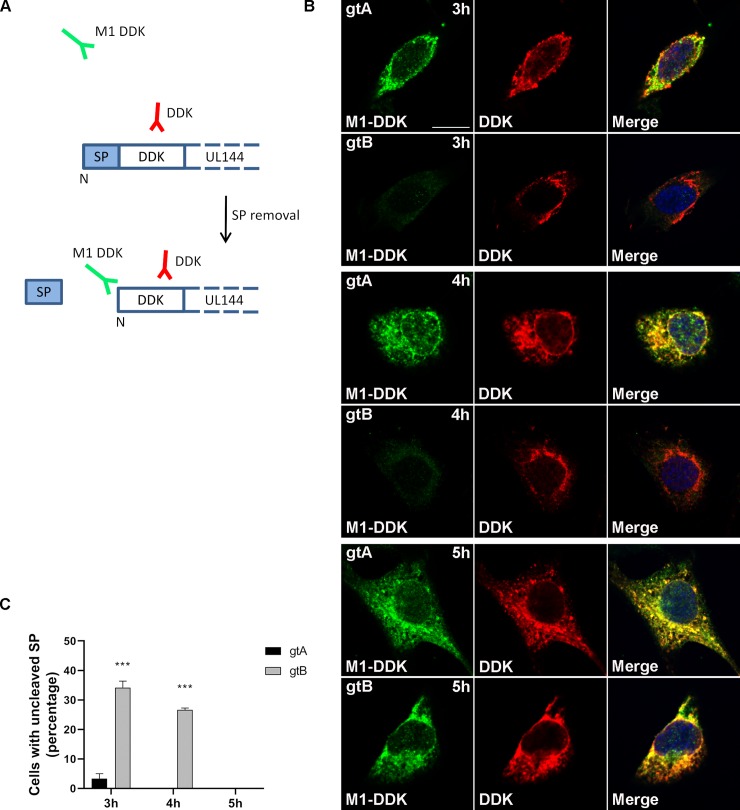
Time-course analysis of signal peptide cleavage.(A) Schematic representation of the vectors used in the experiment. To analyze the removal of the signal peptide from the gtA and gtB variants, a DDK tag was cloned immediately downstream the SP. The DDK tag was detected by using two antibodies: an anti-M1-DDK Ab (green signal) that recognizes only the free N-terminal end of the DDK tag (generated by the cleavage of the SP), and an anti-DDK Ab (red signal) that recognizes the tag independently of its position in the protein and stains all the cells transfected with UL144 variants. (B) HeLa cells were transfected and fixed at different time points. Three, four, and five hours post transfection cells were immunostained with anti-M1-DDK and anti-DDK Abs. Nuclei were counterstained with DAPI. Yellow in the merge images indicates co-localization. Scale bar: 10 μm. (C) Cells only stained with the anti-DDK Ab (red only, indicating an uncleaved SP) were counted, normalized to the total number of analyzed cells and reported as percentage (two way ANOVA; n >60) (***, P < 0.001).